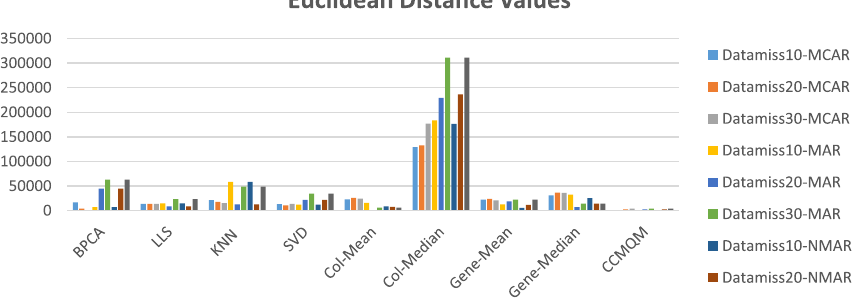
Fig. 4 Euclidean distance test values